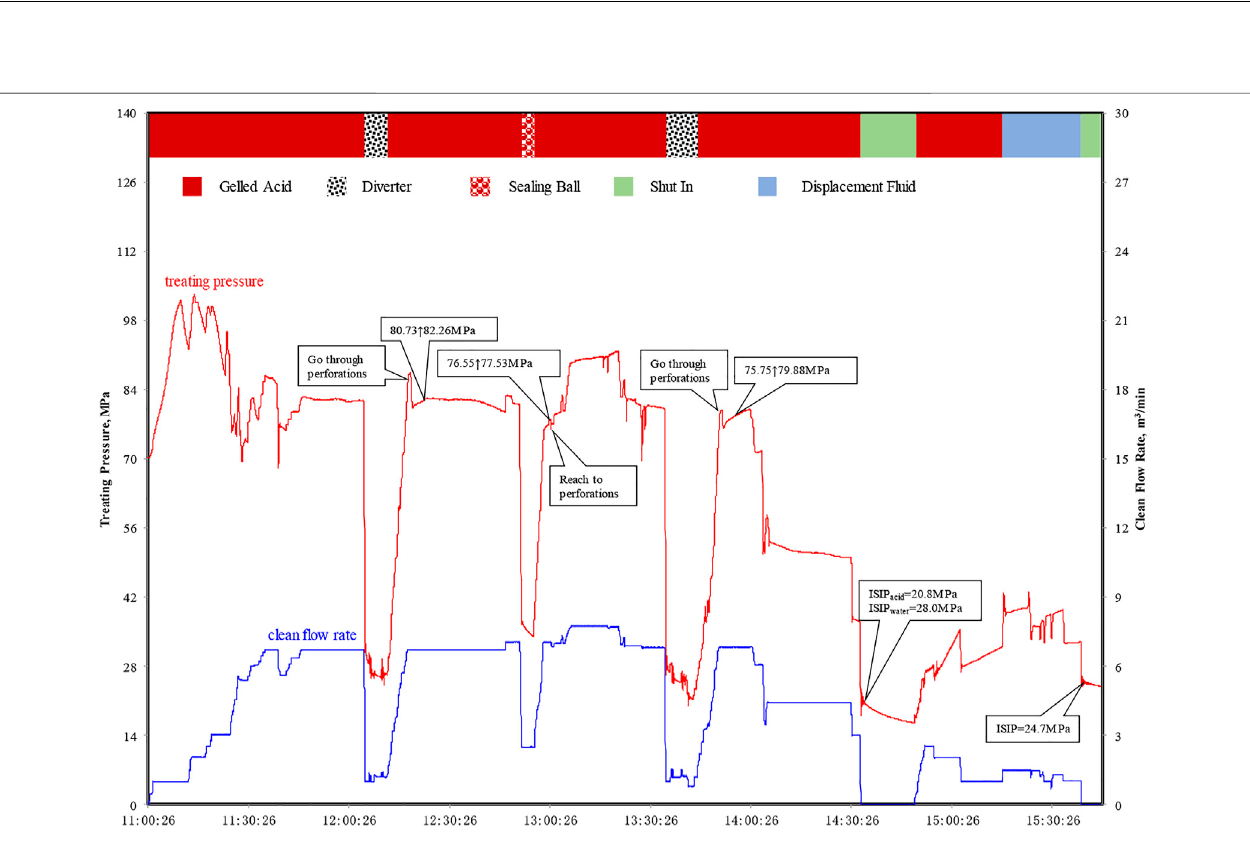
Frontiers in Energy Research |